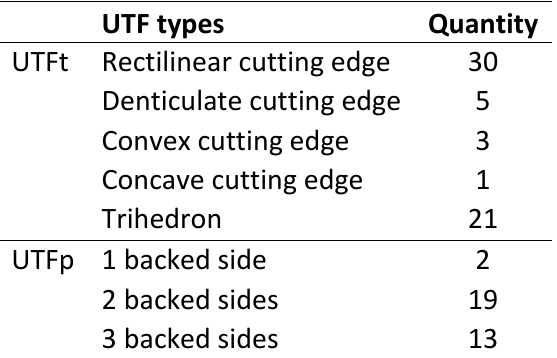
Table 6. presence of UTFt and